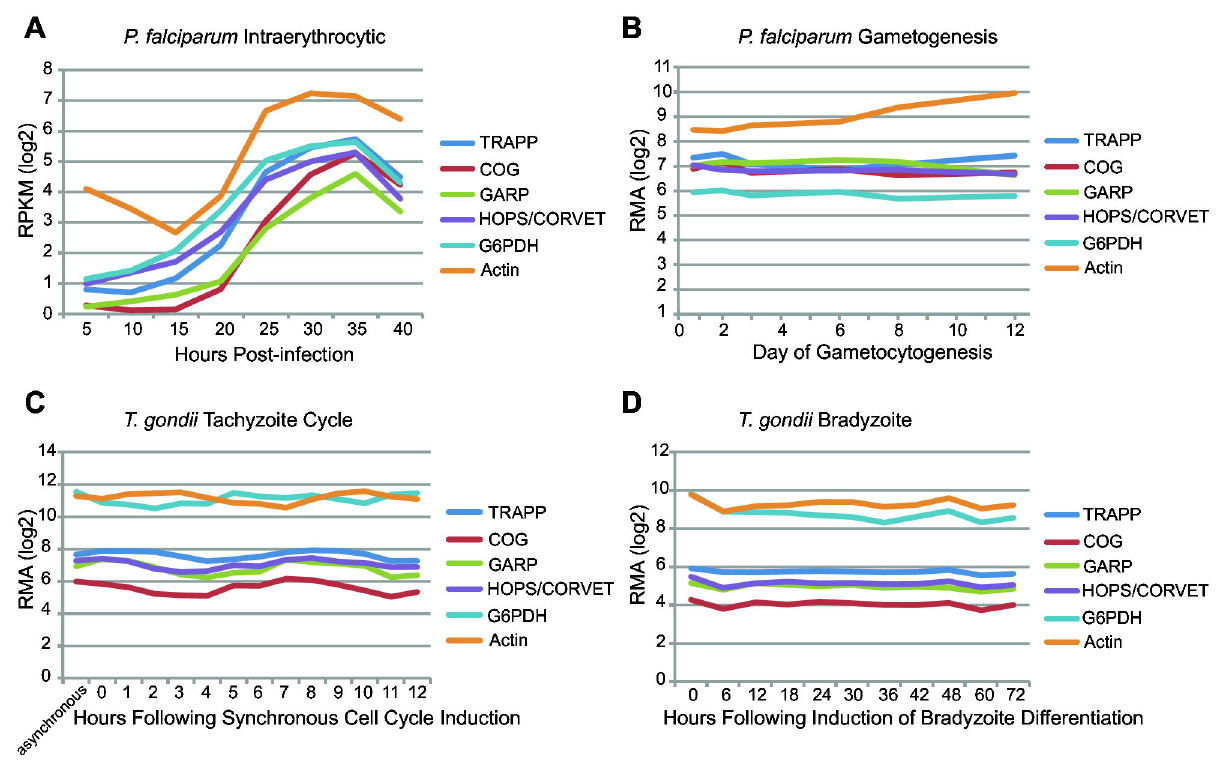
Figure 5. Average level of transcription of MTC subunits in P. falciparum and T. gondii . Data is provided for different lifecycle stages, and compared to the housekeeping genes Actin and G6PDH. As transcription data for each subunit of an MTC showed similar trends, the average of all subunits for each MTC is shown (see Figure S2). In all cases, tethering complex genes are not only transcribed, but have approximately equal levels of transcription and vary with time in a similar nature. This provides evidence for the continued regulation of transcription of these genes. All data was obtained publically from